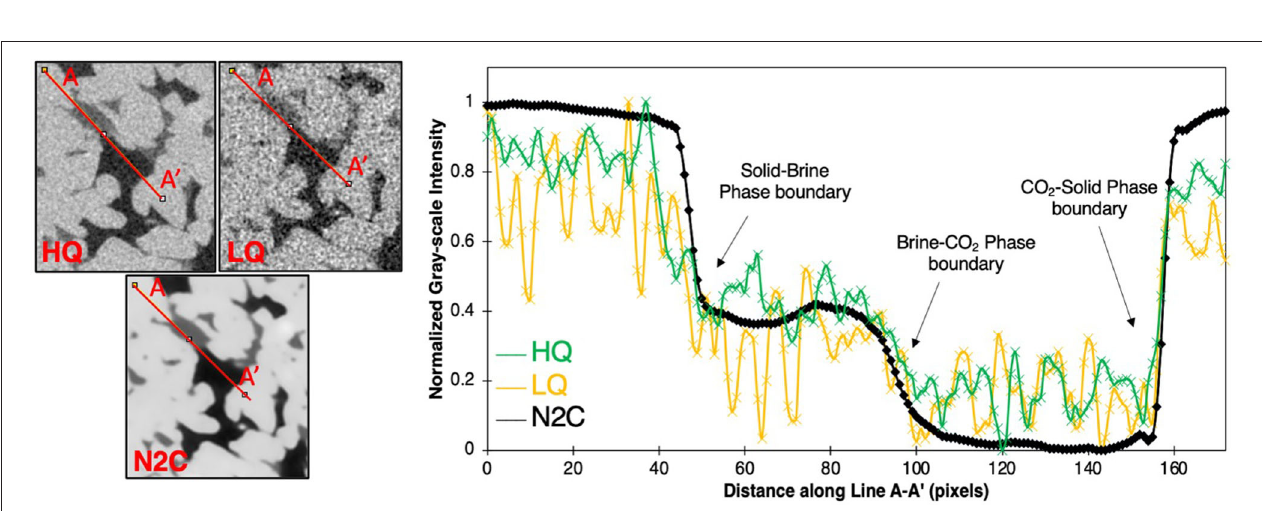
FIGURE 3 | Qualitative comparison of the performance of the different denoising methods through gray-scale histograms.